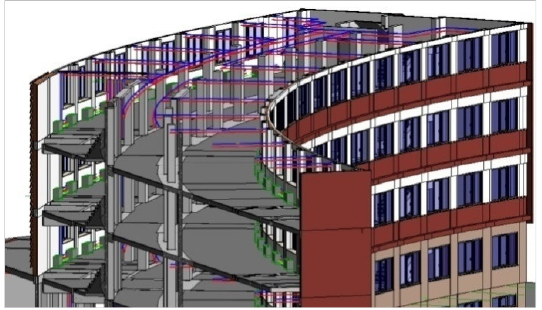
Figure 11: Cross-section with the view of the fan coil power supply system.